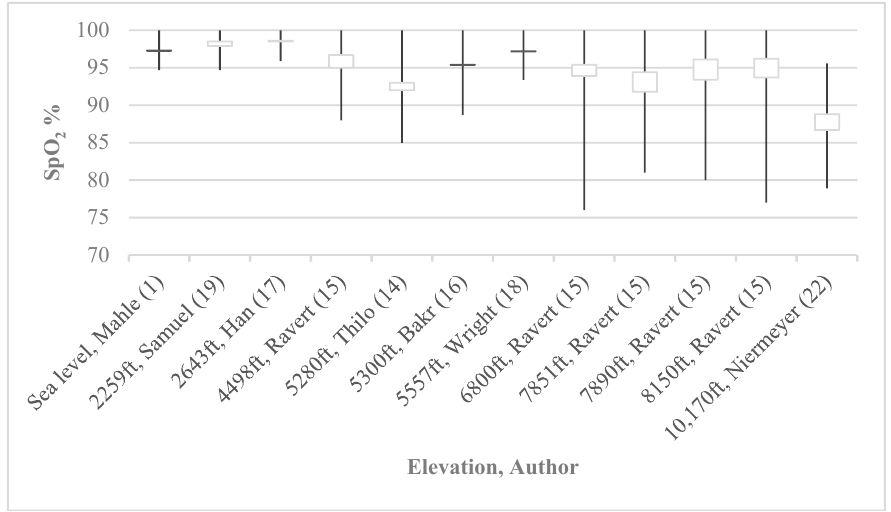
Figure 1. Historical SpO 2 at various altitudes. Average oxygen saturations in newborns are lower and more variable at higher altitudes (closed boxes indicate saturation ranges while whiskers indicate ±2 SD).